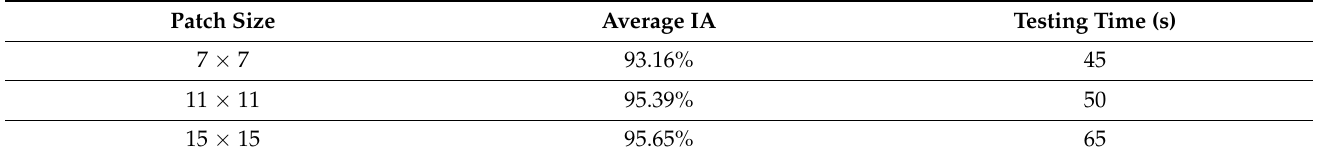
Table 12. Classification accuracy and running time for different patch sizes. Patch